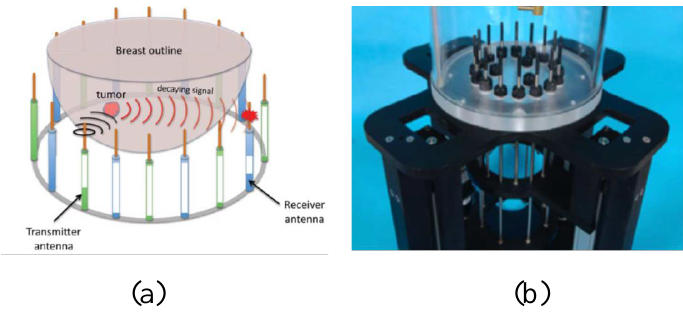
Figure 5. A prototype system for breast cancer testing developed by Grzegorczyk et al. [67]. ( a ) View of a 3D schematic representing the testing setup. ( b ) Photograph showing the system hardware. Reprinted with permission from [67].